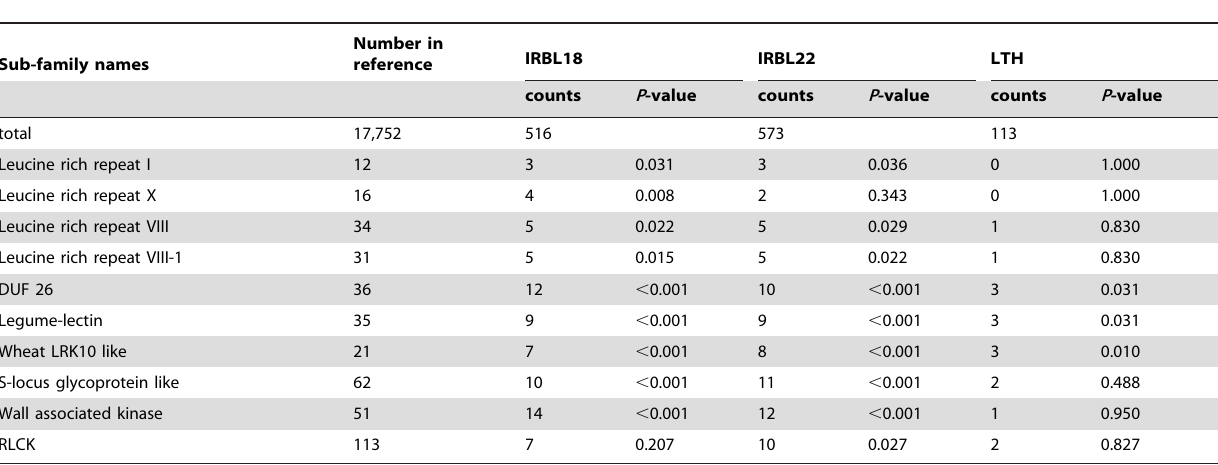
Table 3. The enrichment analysis of receptor kinases in the up-regulated